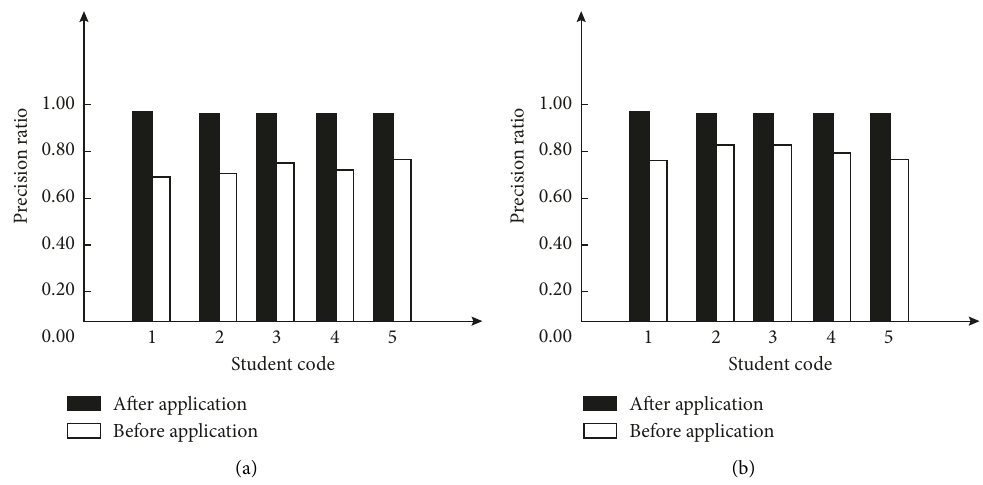
Figure 7: Teaching accurate results. (a) Attention. (b) The accuracy of the problem.